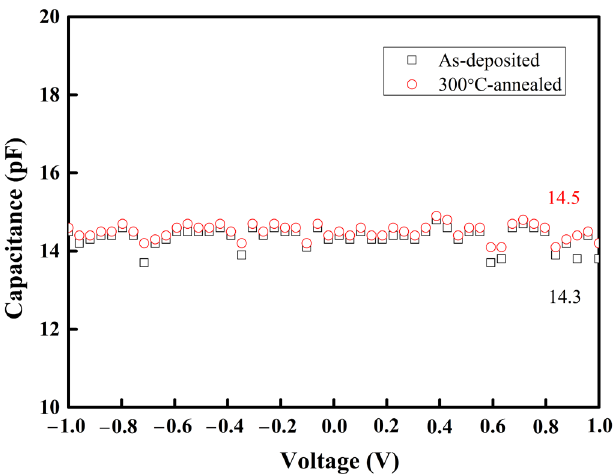
Figure 8. C-V profiles of as-deposited and 300 °C-annealed Mo/SiO x /SiN y /Mo MIM samples.